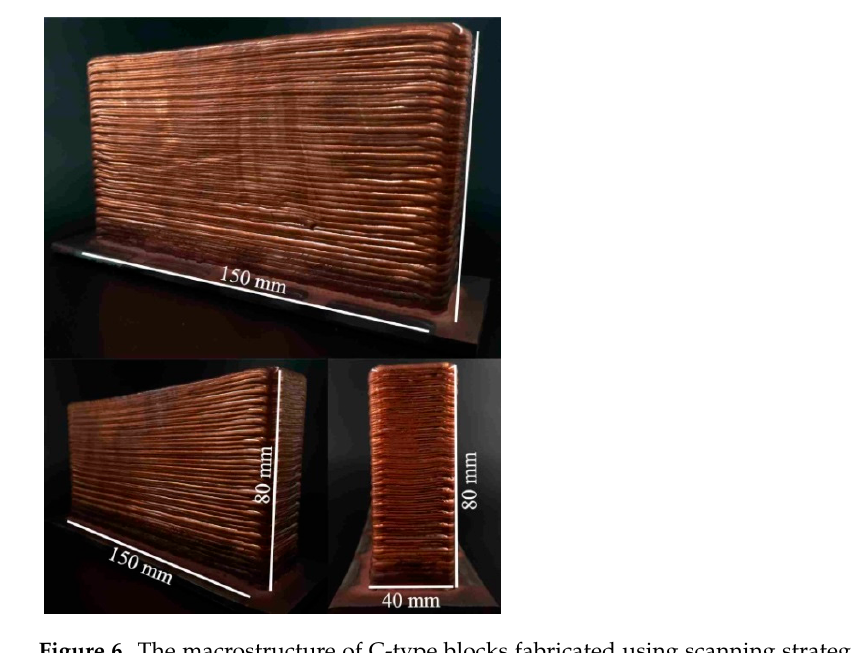
Figure 5. Macrostructure of B-type blocks fabricated using scanning strategy 2 with electron beam wire-feed additive technology. Noted defects by type: 1—droplets, 2—leaks and 3—decrease in the height.